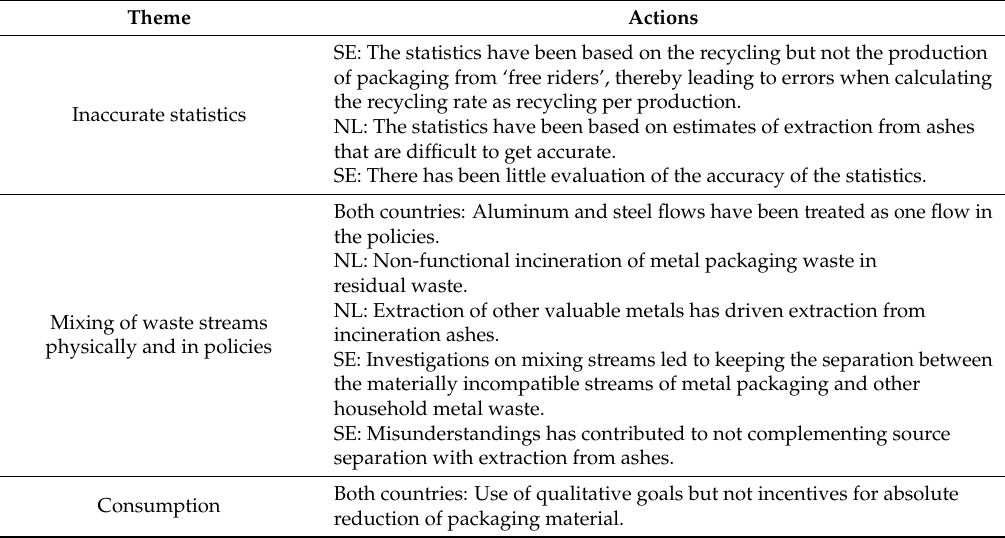
Table 3. Starting points for understanding how actions have influenced the environmental performance of metal packaging flows in Sweden (SE) and the Netherlands